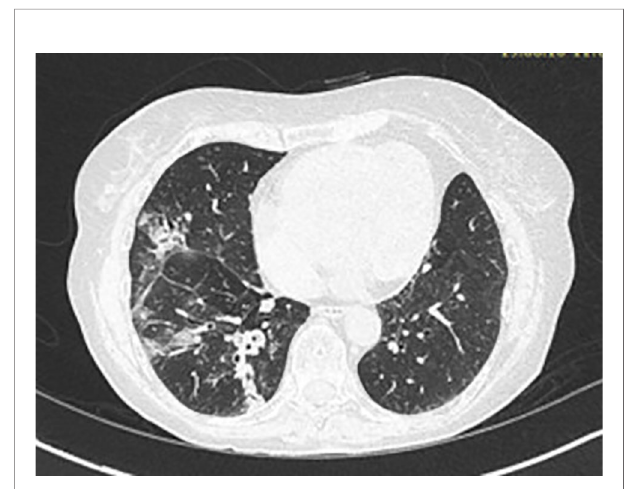
FIGURE 4 | Chest CT scan image showing alveolar opacities associated to bronchiectasis in posterior and medial segment of the right basal pyramid.